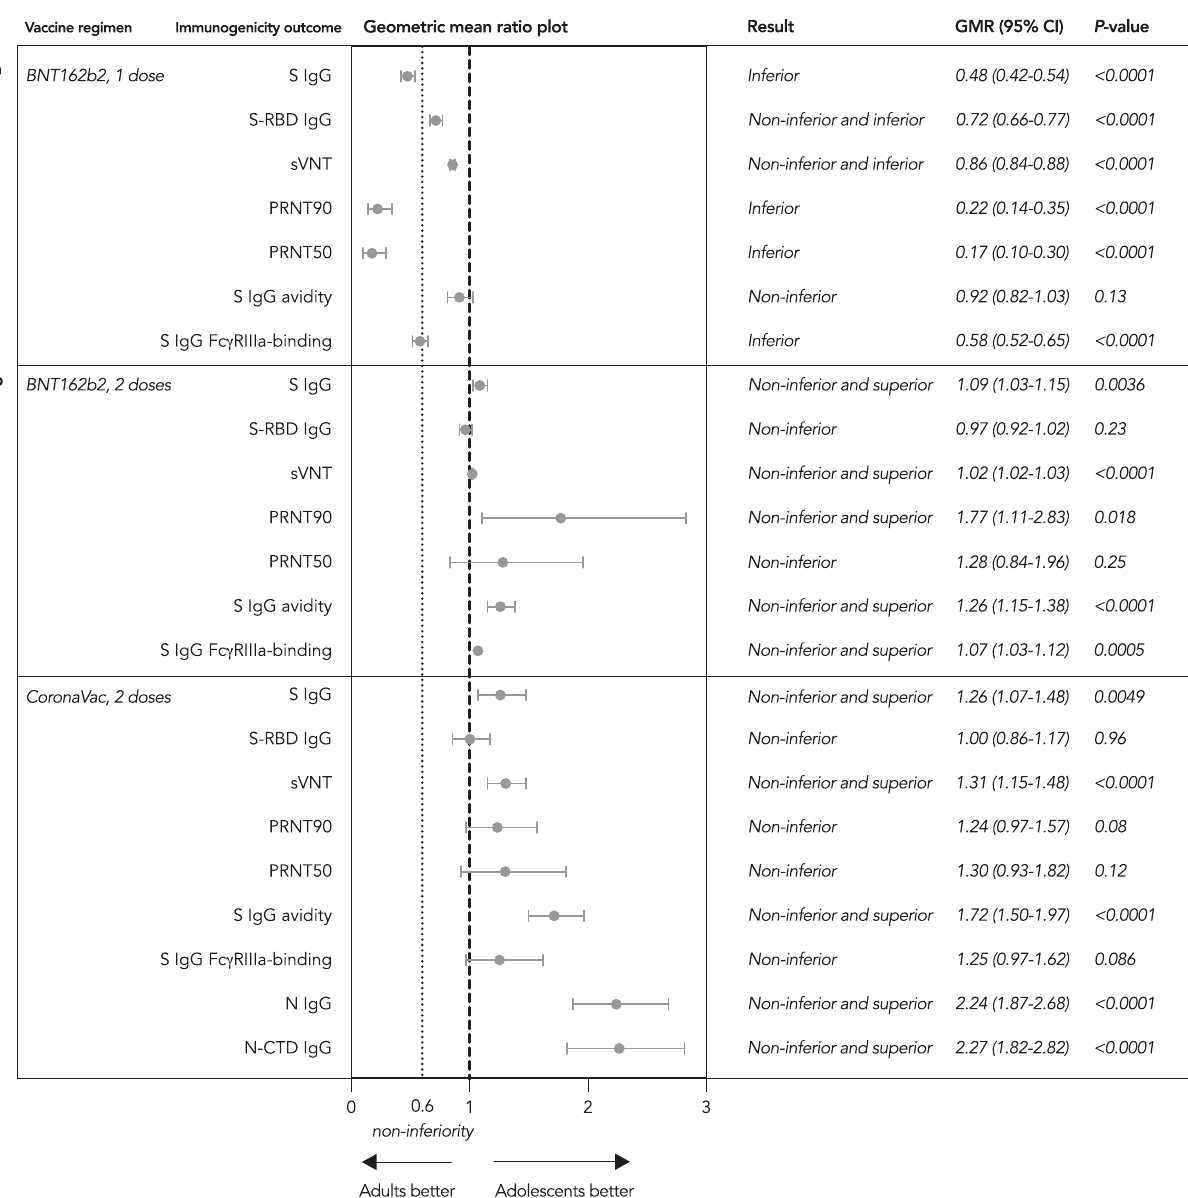
NATURE COMMUNICATIONS| (2022) 13:3700